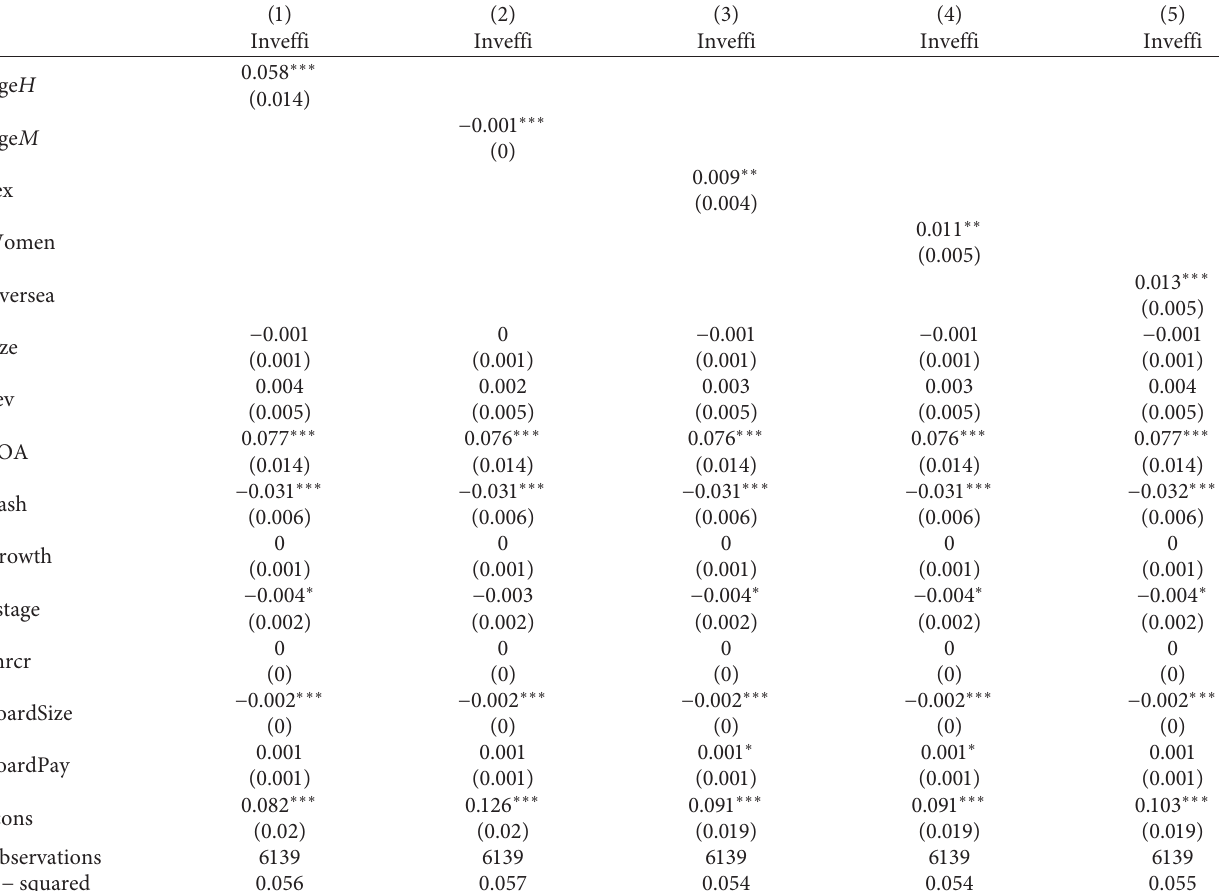
Table 9: Regression results of the relationship between board members’ characteristics and investment efficiency of refinancing companies (robustness test). Inveffi Inveffi Inveffi